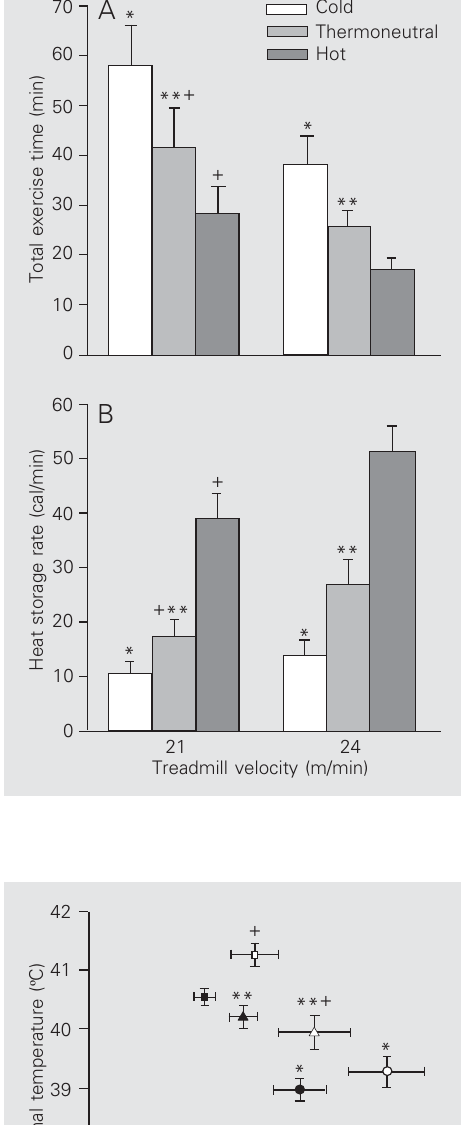
Figure 2. Final internal tempera- ture of untrained rats during treadmill exercise (21 or 24 m/min) in a cold (18 (cid:1) C wet bulb globe temperature, WBGT), thermoneutral (23.1 (cid:1) C WBGT) or hot (29.4 (cid:1) C WBGT) environ- ment. Data are reported as means ± SEM for 6 rats. *P<0.05 compared to the ther- moneutral and hot environ- ments; **P<0.05 compared to the hot environment; + P<0.05 compared to 24 m/min in the same environment (Student t-